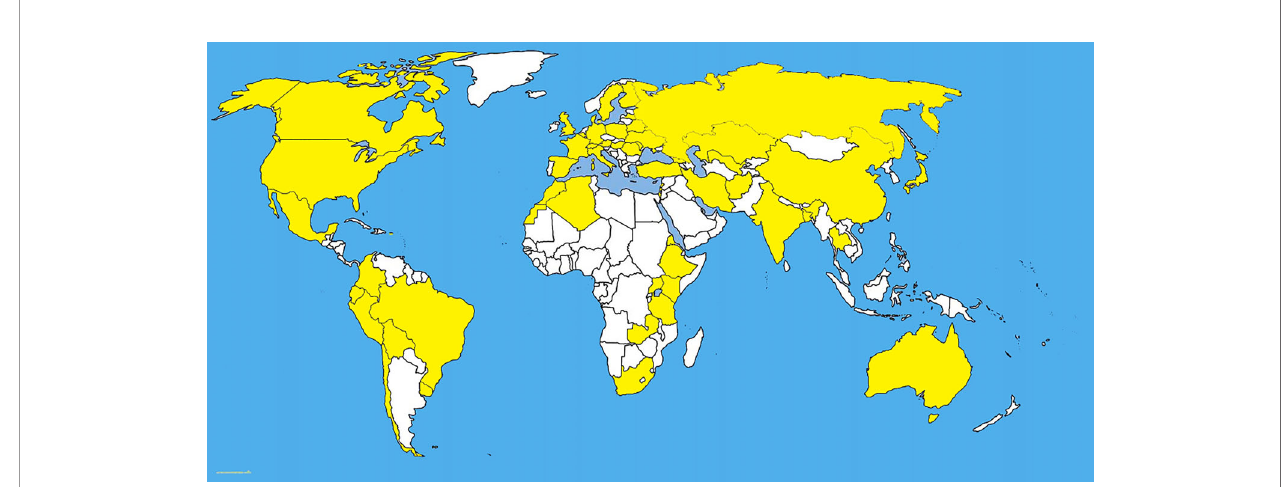
FIGURE 1 | The distribution map of Pyrenophora tritici-repentis . The areas where infection have been reported are indicated in yellow (www.cabi.org/isc. Accessed on 25/03/2021).